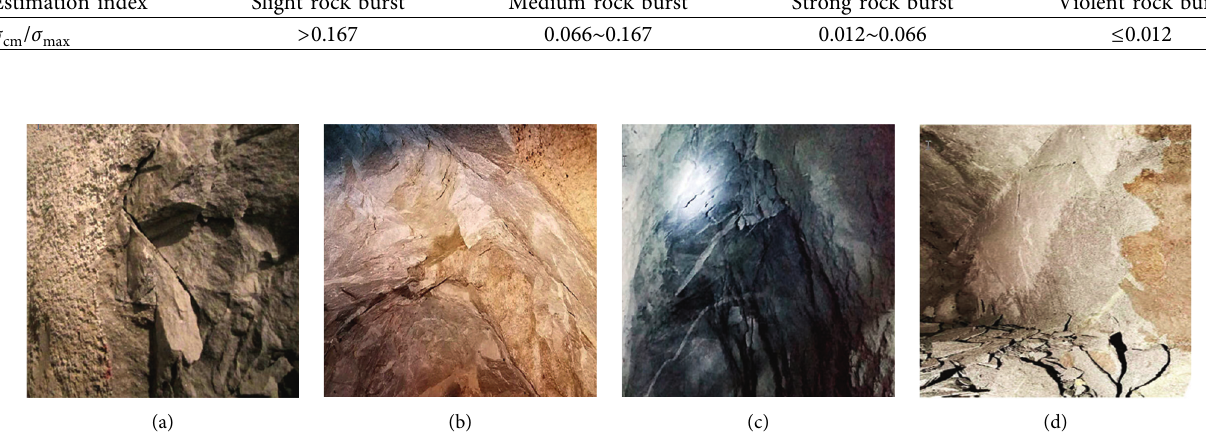
Table 9: Calculation of rock burst grades at 4 verification points using the ratio of σ